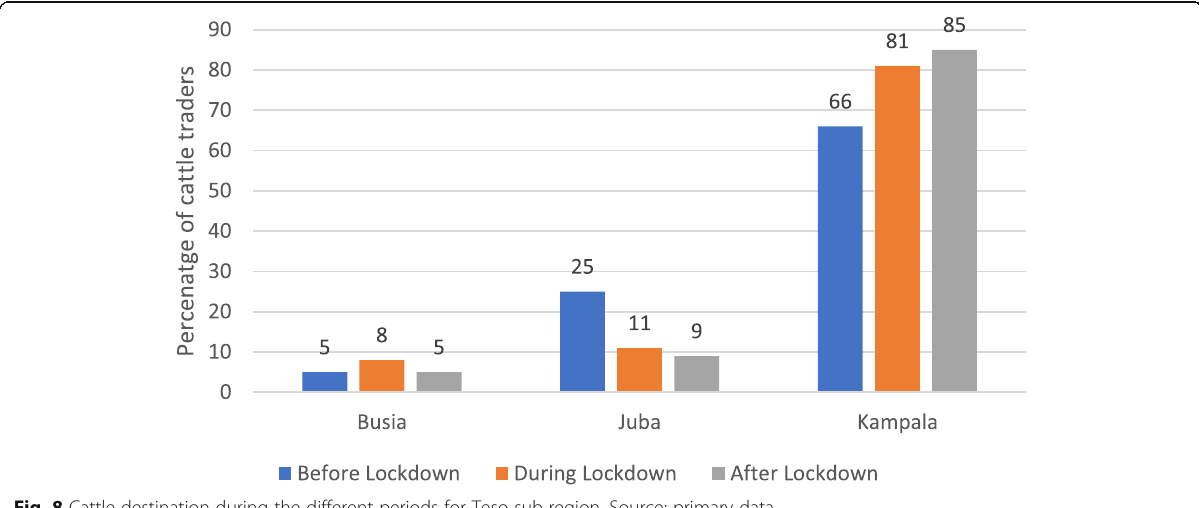
Fig. 8 Cattle destination during the different periods for Teso sub-region. Source: primary data